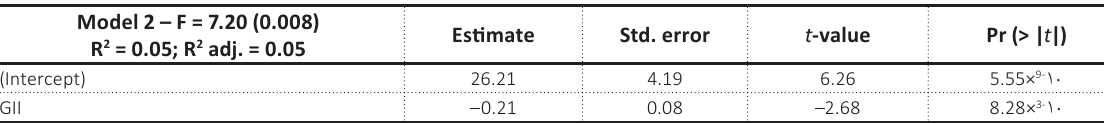
Table 4. Regression analysis – model